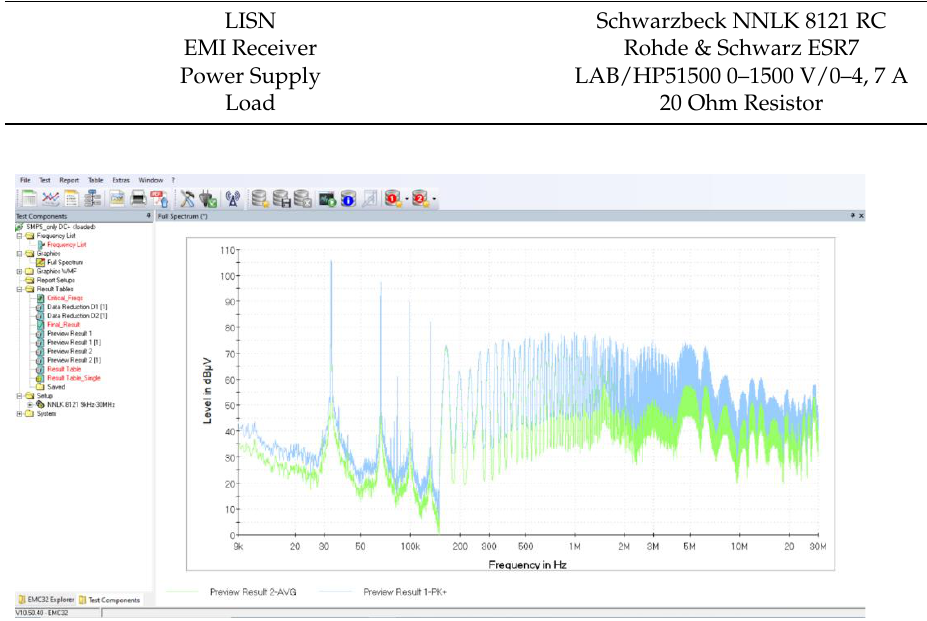
Figure 23. Conducted emission measurement result. EMC32 (Rohde & Schwarz, Germany, Munich) software view. Table 2. Parameters of the measurement set in EMC32 Studio.